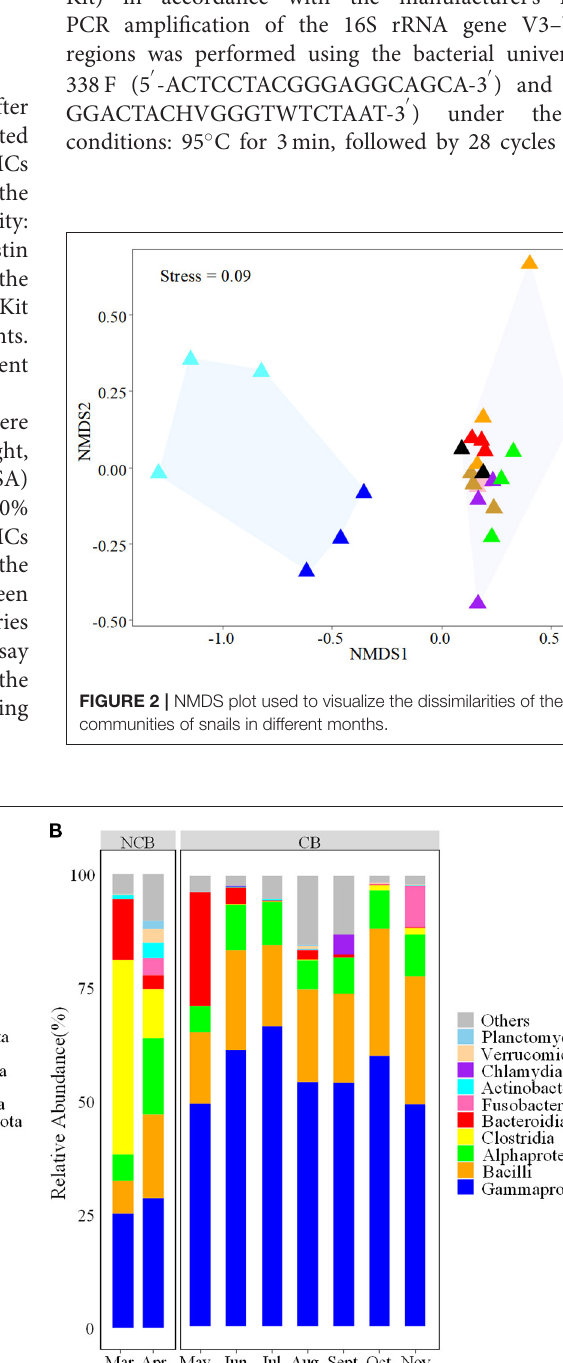
Frontiers in Microbiology |